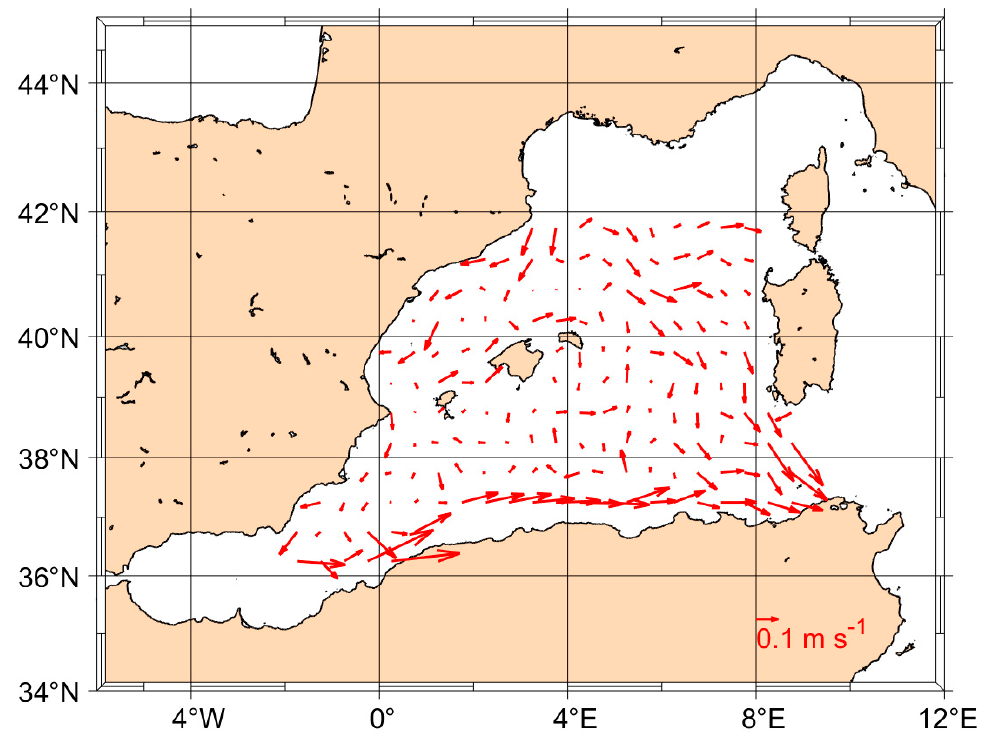
Figure 3. Mean surface velocities obtained by the pseudo-Eulerian analysis of all the drifter trajectories crossing the area of study from 1985 to 2016. The dimension of the bins is 0.5° × 0.5°. Here, the signal of the WMMC, described by Pinardi et al. [12] as a residual current after multi-year averaging and of the WSC [14], is